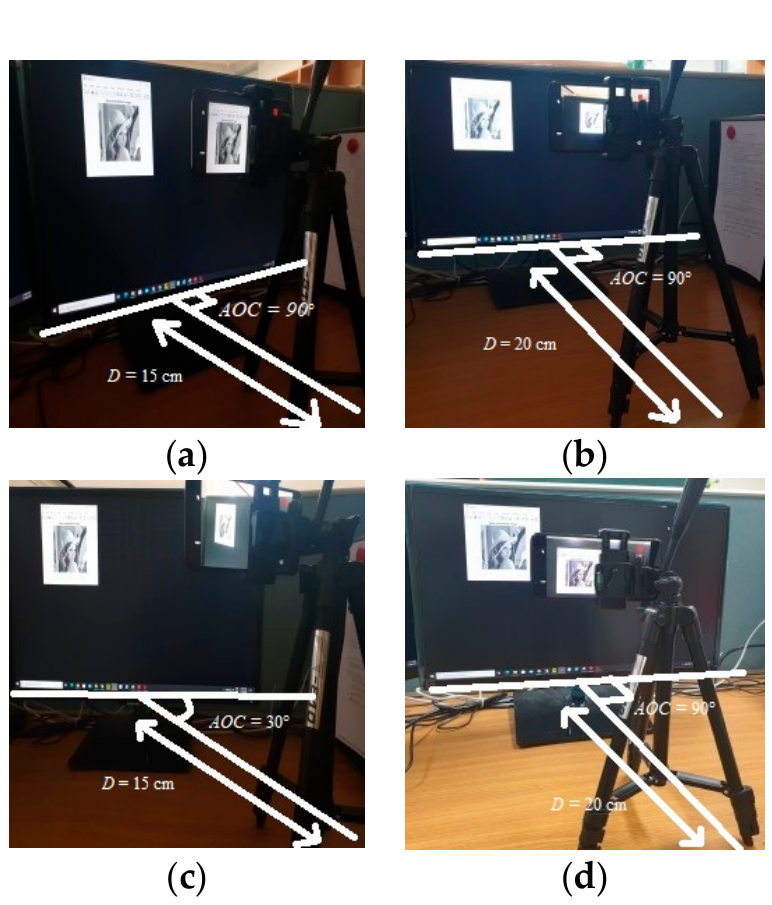
Figure 6. Experiments conducted under various lighting conditions. ( a ) Normal lighting, ( b ) normal lighting with a varying distance, ( c ) normal lighting with a varying angle, and ( d ) ambient lighting.